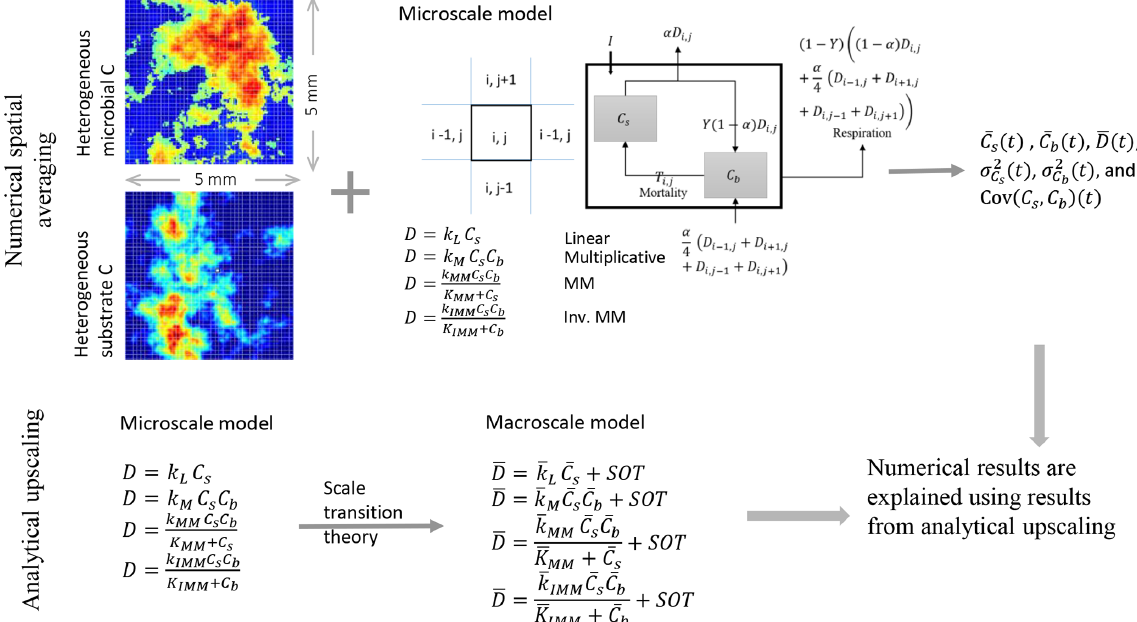
Figure 1. Schematic of the two upscaling approaches used to study the C dynamics at the macroscale. Numerical spatial averaging (top): the microscale model is applied at each grid cell of the heterogeneous domain; the mean C pools (substrate C s and microbial biomass C b , where the overbar indicates spatial averaging), their mean fluxes, and second-order spatial moments Eqs. (24)–(29) at each time step. This approach is referred to as the “distributed model”. Analytical upscaling (bottom): the microscale decomposition flux is dynamically scaled up using scale transition theory, which provides the mean C fluxes as a function of mean C concentrations (mean field approximation) and second-order spatial moments representing the degree of heterogeneity. The deviations from the mean field approximation are denoted as “second-order terms” (SOTs) in the expressions of the mean decomposition fluxes ( D , where the overbar represents mean quantities). The numerical results obtained from the distributed model are explained using the mathematical expression derived from analytical upscaling. This upscaling scheme is applied to four types of decomposition kinetics (linear, multiplicative, Michaelis–Menten, and inverse